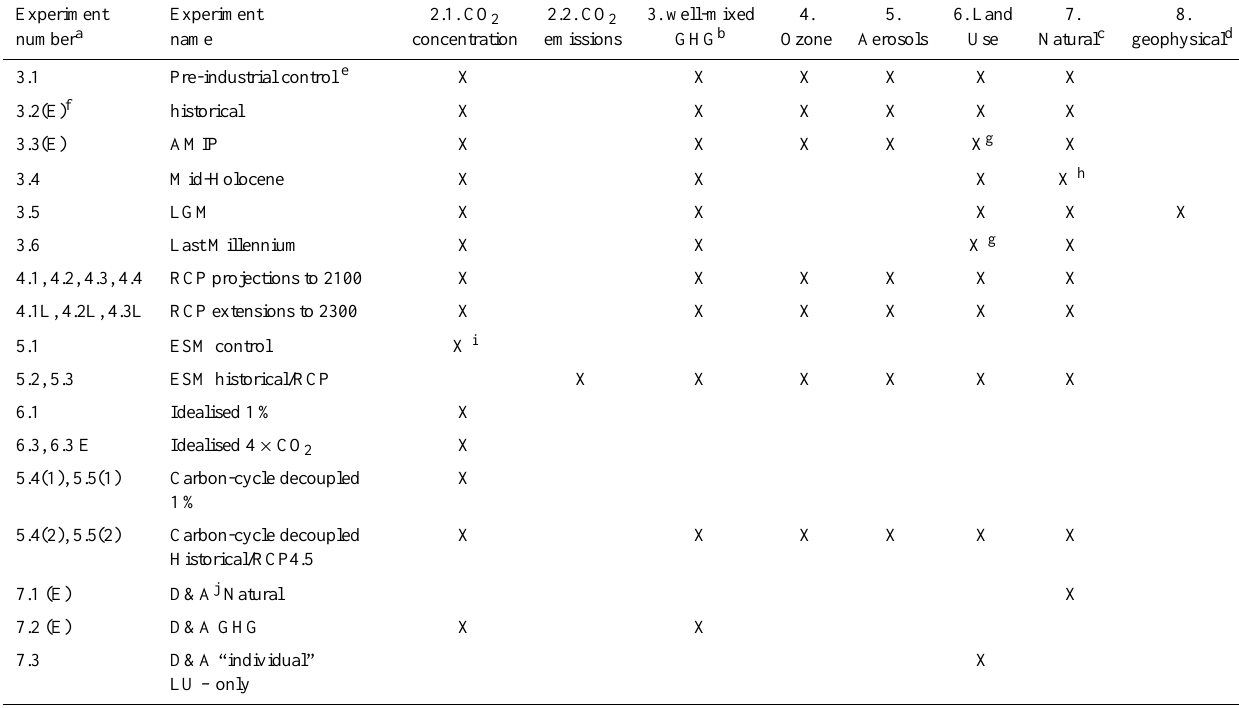
Table 1. Overview of CMIP5 experiments and their prescribed boundary conditions, i.e., atmospheric concentrations or emissions. This Table lists the climate forcings required to be changed from the control run (Experiment 3.1) in order to set-up and perform each CMIP5 experiment. The presence of a cross denotes that that forcing is changed, and is documented in the section listed in the column title. An absence of a cross does not mean that forcing is missing, but that it is kept the same as in the control